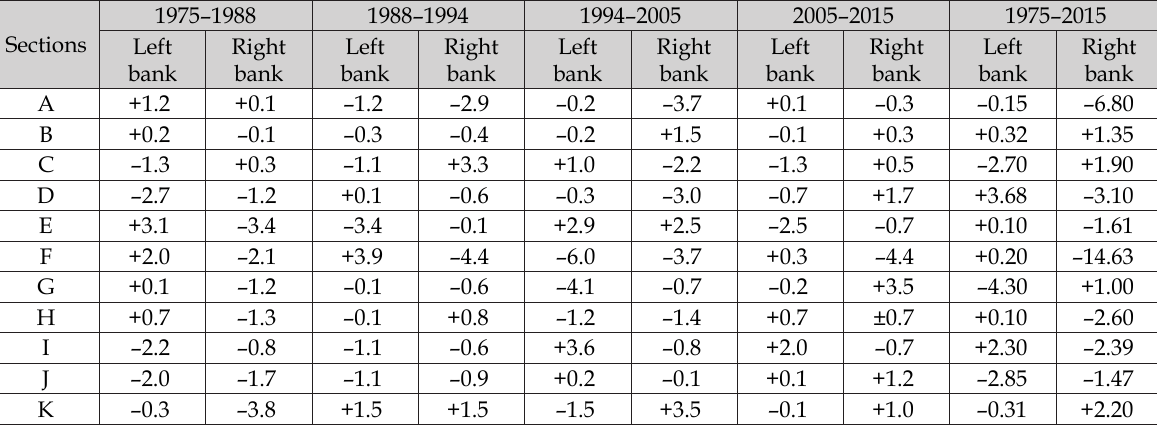
Table 3. Bankline shifting due to erosion and accretion